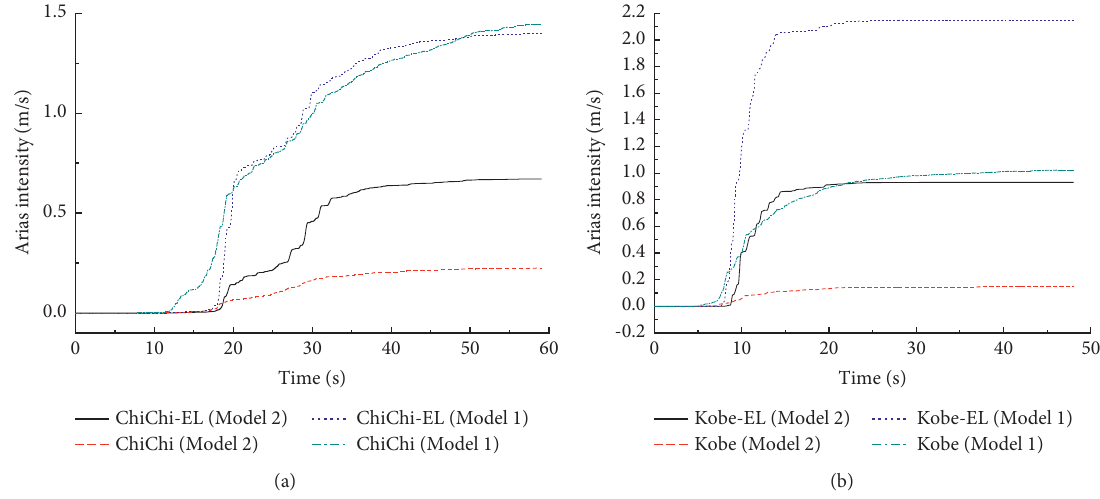
Figure 9: Time-domain response of Arias strength: (a) Chichi and (b) Kobe.